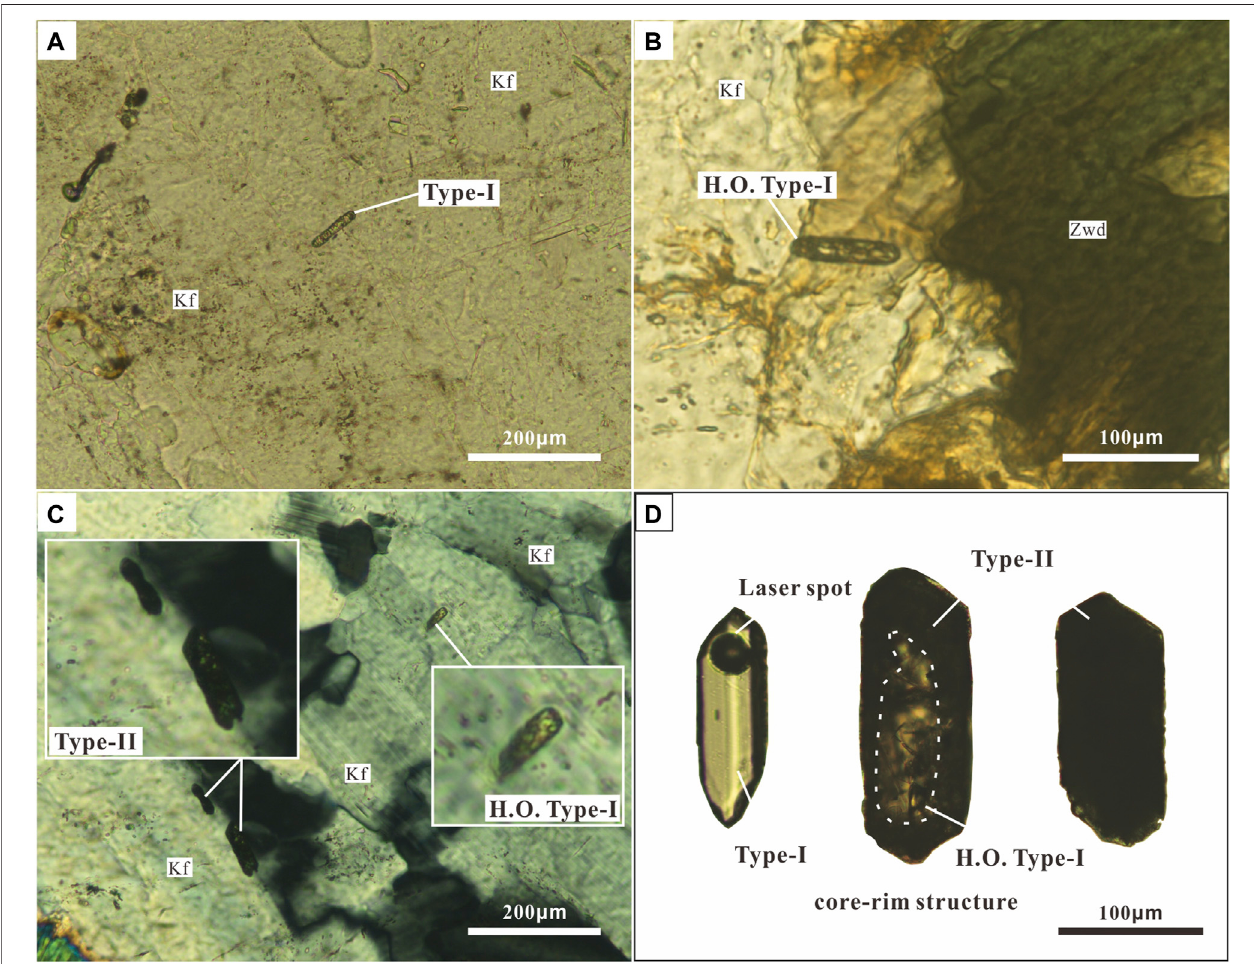
FIGURE 4 | Transmitted – light microscopic images of zircons from the BST pluton. H.O. type-I – hydrothermal overprinting type – I zircon. (A) Type – I zircon embedded in the K-feldspar crystal. Single polarizer. (B) H.O. type – I zircon contact with zinnwaldite. Single polarizer. (C) H.O. type – Izircon embedded in the K-feldspar and thetype – II zircons contact with K-feldspar. Crossed polarizers. (D) Photomicrographs showing thefeatureofdifferent types ofzircons.The black circle inthe type – I zircon is the laser spot. Single polarizer.